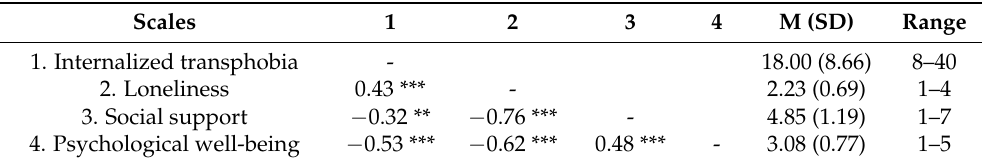
Table 2. Correlations between internalized transphobia, loneliness, social support, and psychological